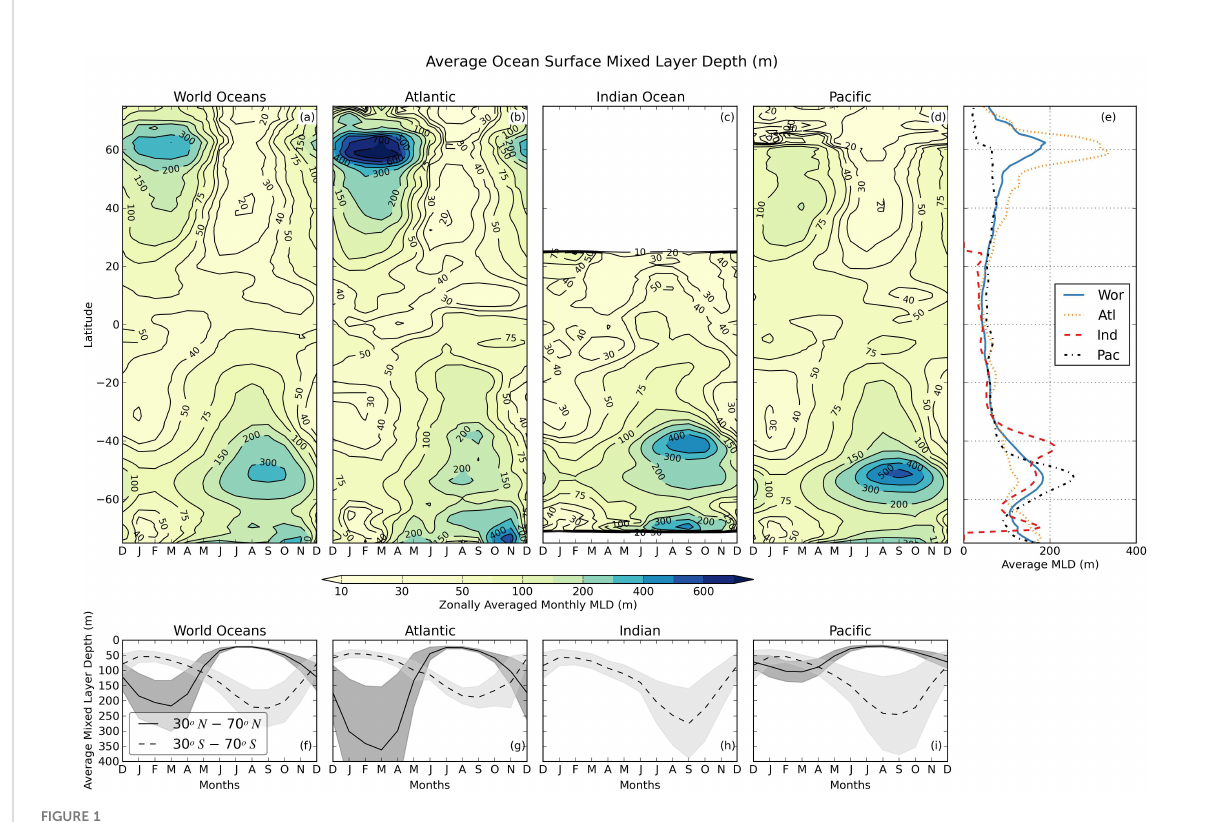
FIGURE 1 Average climatology of mixed layer depth (MLD) in meters. Zonally averaged monthly MLD for the (A) World, (B) Atlantic, (C) Indian, and (D) Paci fi c Ocean. Same colorbar is used for panels (A – D) as shown below them. The contour lines are 20, 30, 40, 50, 75, 100, 150, 200, 300, 400, 500, 600 and 700m. (E) Zonal and annual average of MLD as a function of latitude for the World Ocean and the three major ocean basins. Zonally averaged monthly time series estimate of the mixed layer depth for the subtropics and mid-latitudes between 30° and 70° for both Northern Hemisphere (NH, solid black) and Southern Hemisphere (SH, dashed black) for (F) World, (G) Atlantic, (H) Indian, and (I) Paci fi c Ocean, respectively. The shadow areas in (F – I) represent the data variability between one standard deviation (SD) above and one standard deviation below the average. The standard deviation is estimated based on the zonal averages shown in the plots (A – D)